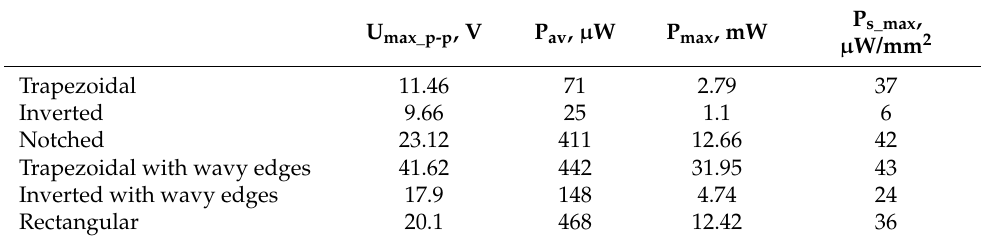
Table 7. Experimentally obtained voltage and power values.